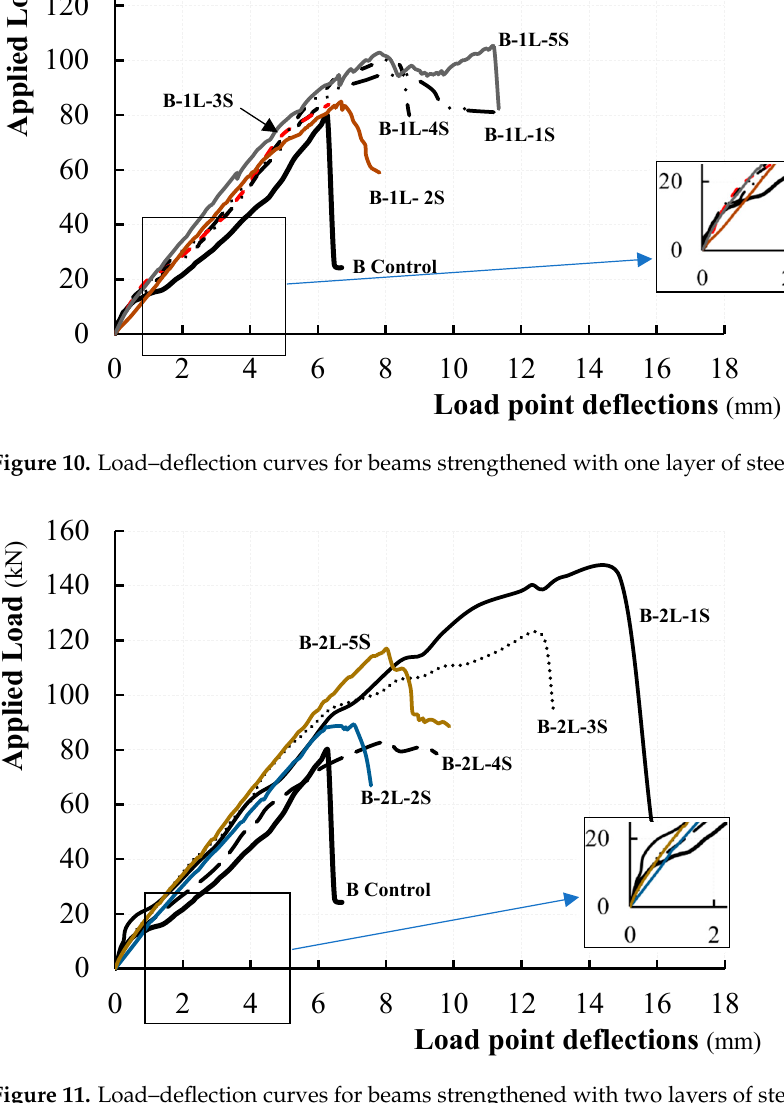
Table 3. Test results.